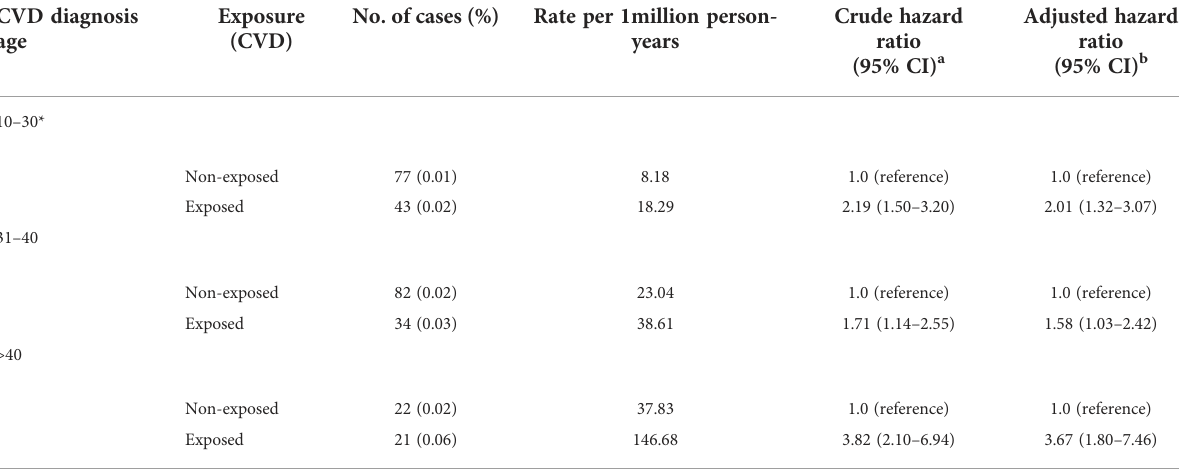
TABLE 2 Associations of overall CVD with lung cancer mortality by age at CVD diagnosis. CVD diagnosis